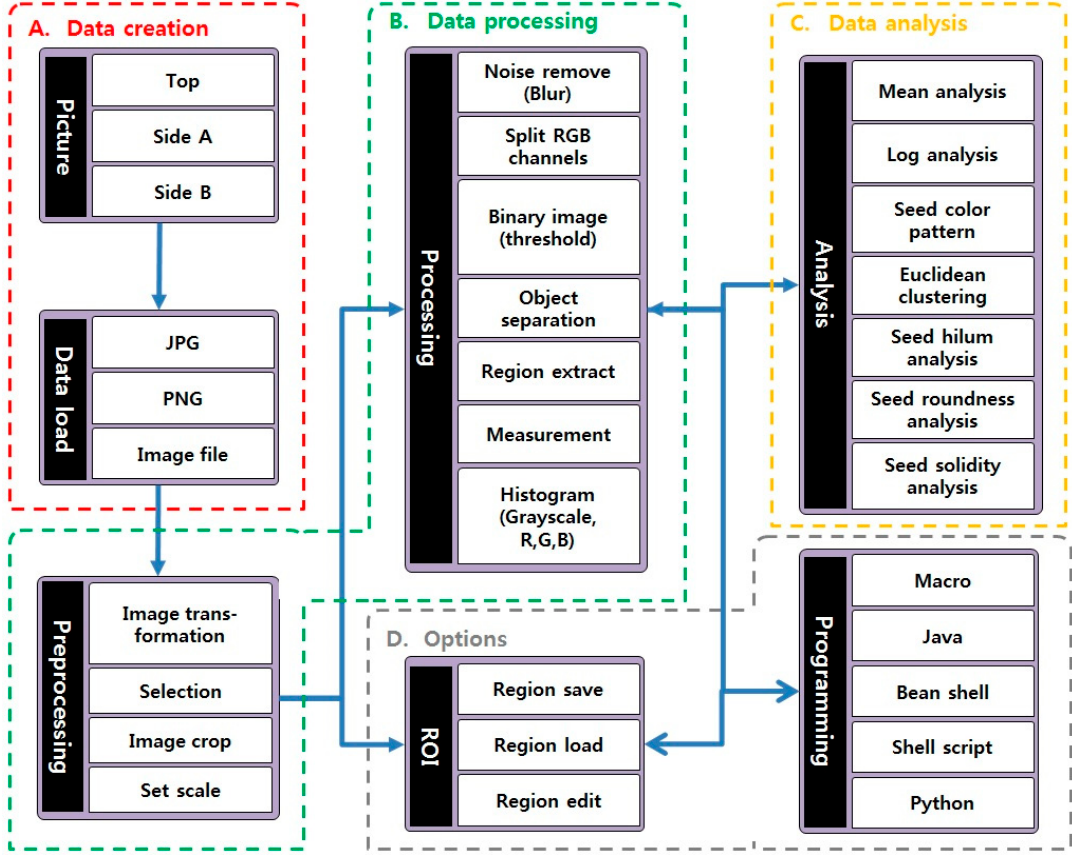
Figure 1. Flow-chart for high-throughput soybean seed phenotype analysis. The picture using raw image file is divided into four. ( A ) Data creation; ( B ) Data processing; ( C ) Data analysis; ( D ) Options.